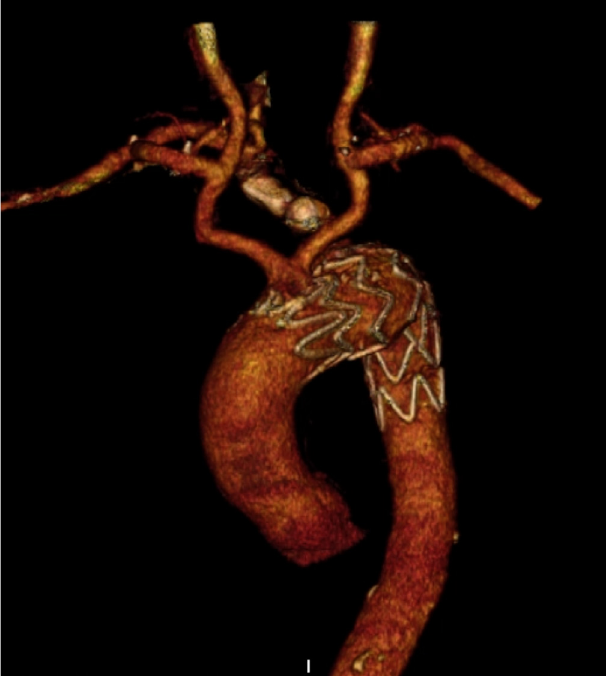
Fig. 2 - Six Month after operation CT-A 3D